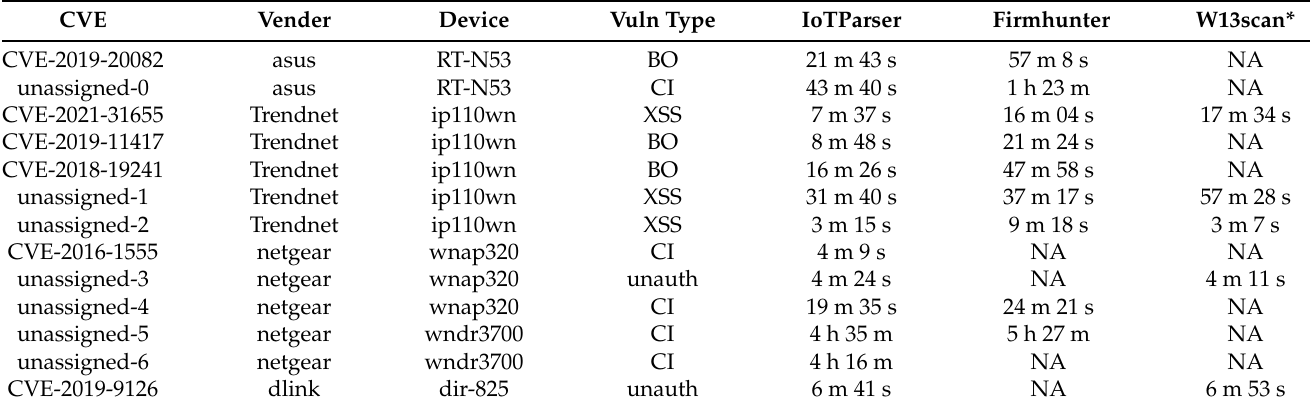
Table 2. Experimental results of IoTParser, Firmhunter, and W13scan*. unassigned-num refers to the serial number of the 0-day vulnerability